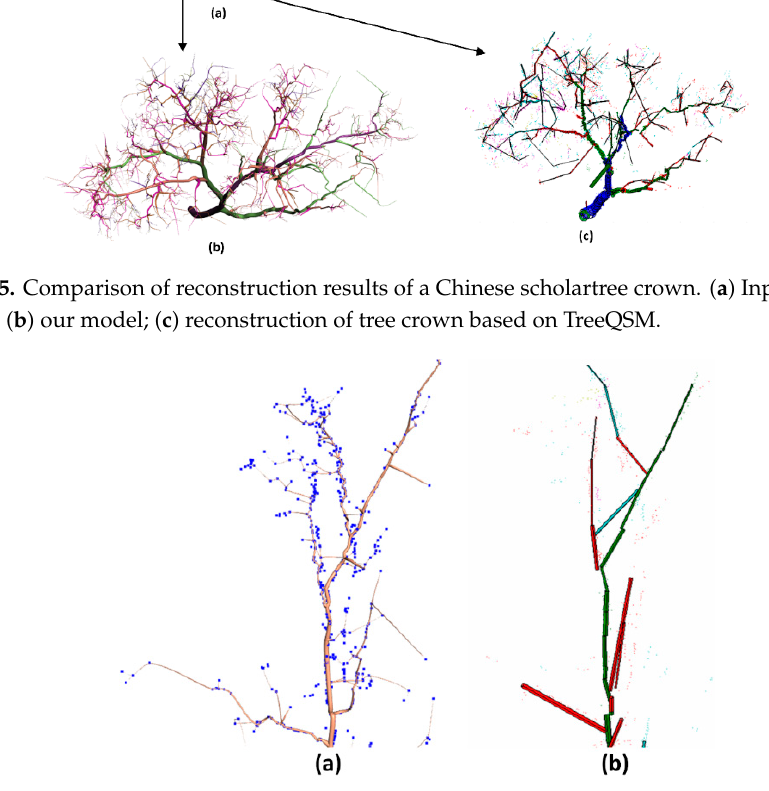
Figure 16. Comparison of our branch model and TreeQSM. ( a ) Our model; ( b ) tree branch reconstruction based on TreeQSM.